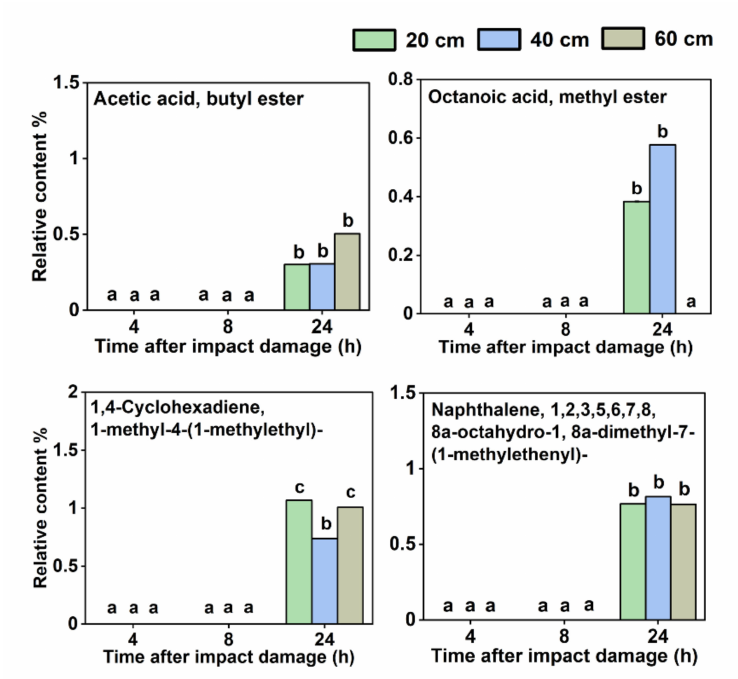
Figure 5. Four VOCs detected only in the later stage of storage after the fruit had been impacted. Different letters (a, b, c, d) indicate significant differences ( p <